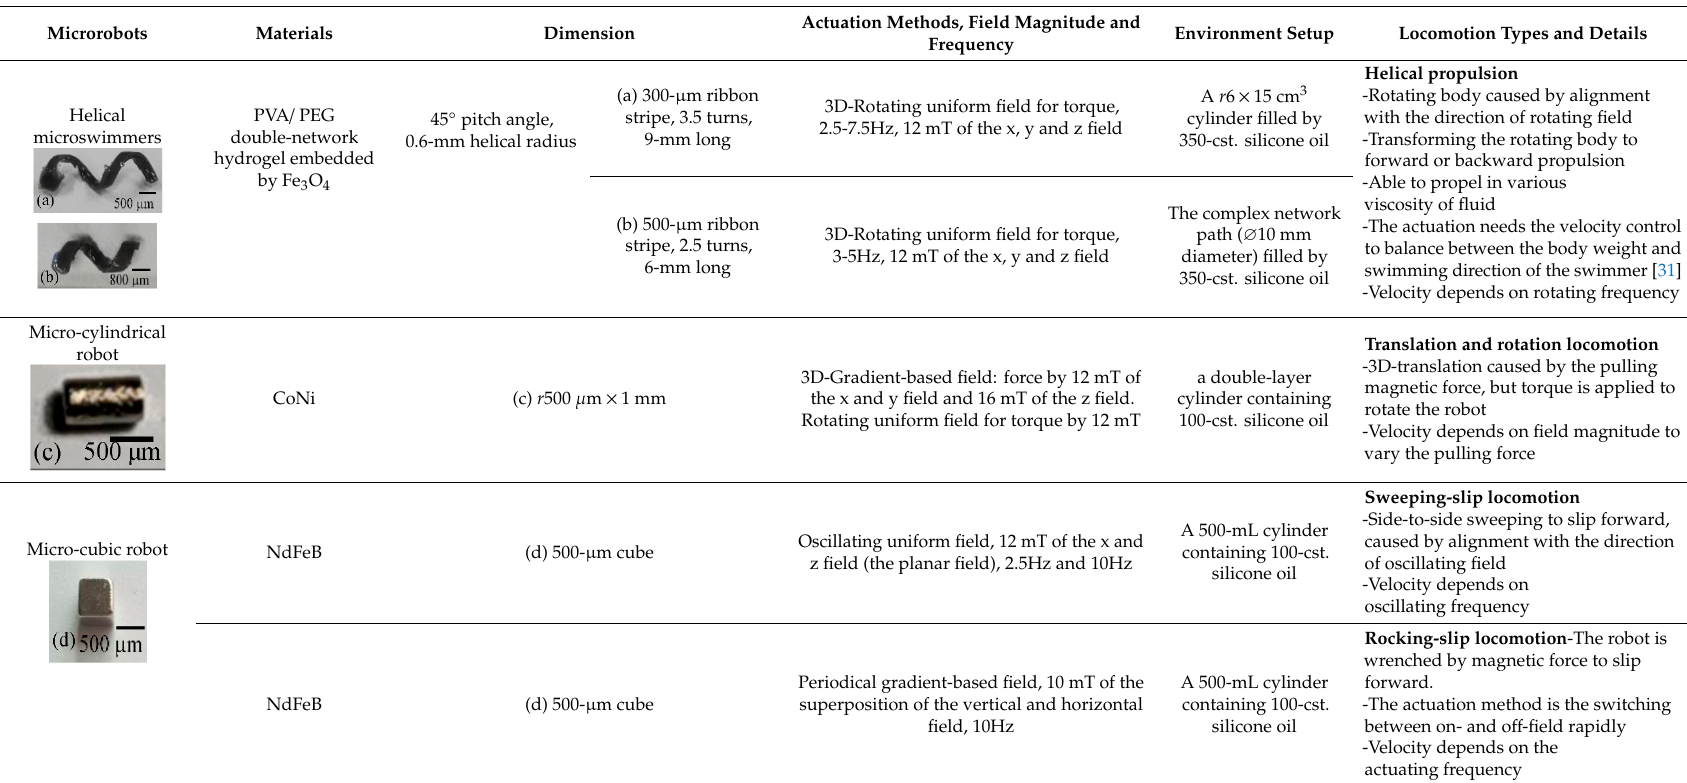
Table 3. Microrobots: specifications and control parameters.